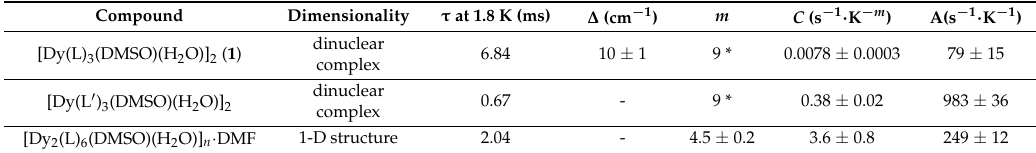
Table 1. Comparison of magnetic parameters for the different